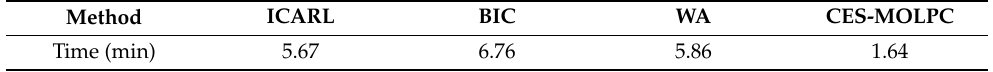
Table 7. Algorithm running time comparison on RML2016.04c data set ( T = 2).